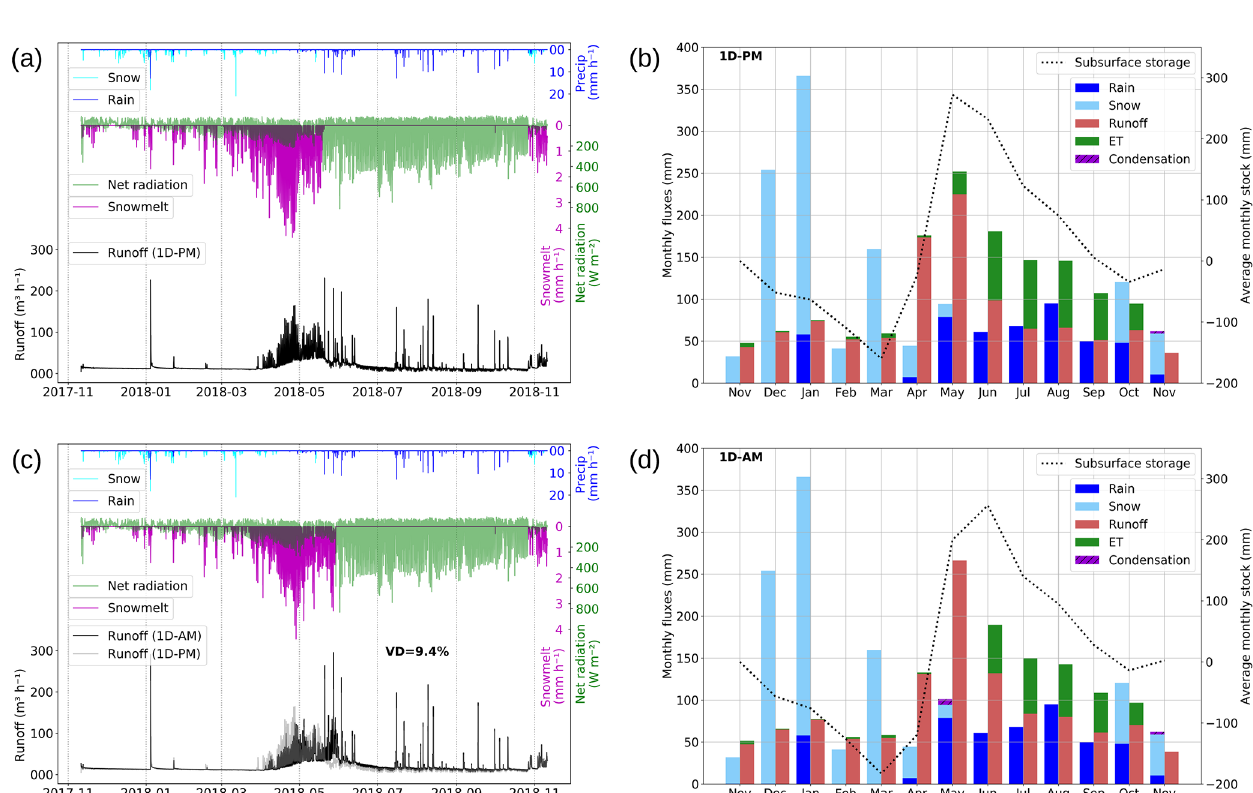
Figure 5. (a) Precipitation (rain in blue and snow in light blue), streamflow (black), snowmelt (magenta), and net radiation (green) regimes along the simulation period for the only precipitation distributed mean simulation (1D-PM). (b) Monthly water budget for the 1D-PM simulation, including rain (blue), snow (light blue), runoff (red), ET (green), and condensation (purple). The dotted black line is the total subsurface water storage. Panels (c, d) are the same as (a) and (b) but for the all distributed mean simulation (1D-AM). VD is the volume difference between plotted simulations as a